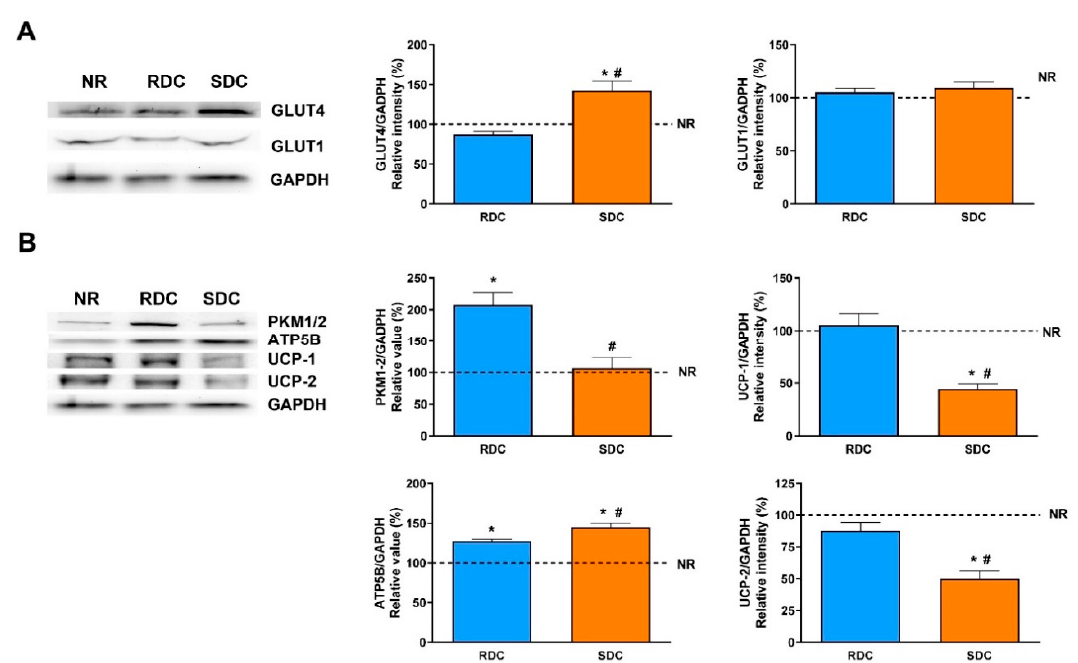
Figure 3. Adipose tissue expression of glucose transporters and enzymes in the experimental groups. ( A ). Glucose transporters. ( B ). Enzymes related to the glycolytic pathway. NR group, not restricted; RDC group, re ‐ feeding with rapid digestible CHO diet; SDC group, re ‐ feeding with slow digestible CHO diet. * Significant difference with NR group, p < 0.05. # Significant difference with RDC group, p < 0.05.